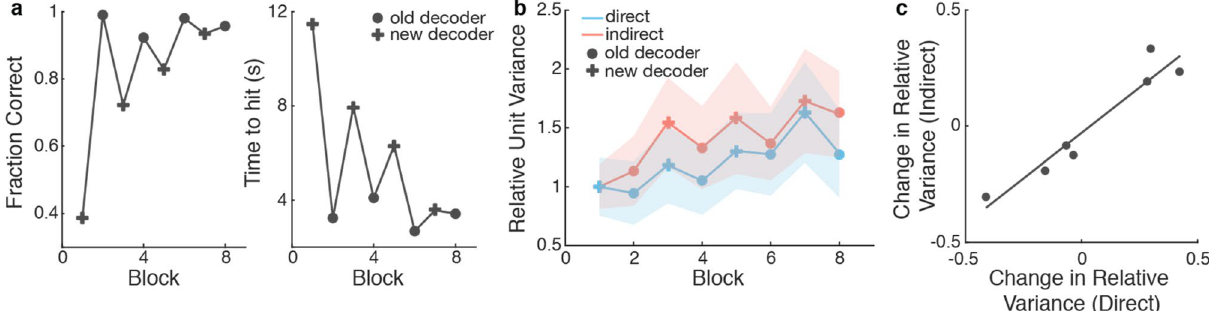
Figure 5. Neural variance modulates concomitantly between subpopulations. ( a ) Monkey P learned to perform BMI with a new decoder following proficient control with the old decoder. 8 experimental blocks were performed, alternating between a new decoder (cross) and the previously learned decoder (circle). Fraction of initiated trials that were successful increased over training blocks (left) and the time to reach a target decreased over training blocks (right). ( b ) Both subpopulations increase their neural variance over blocks (Linear regression; Direct R 2 = 0.623, p = 0.020, Indirect R 2 = 0.655, p = 0.015). The relative variances across blocks are correlated between subpopulations (Pearson’s r, r = 0.856, p = 0.007). ( c ) Each point represents the change in relative variance between two consecutive blocks. The changes in relative variance within the direct and indirect subpopulations are correlated (Pearson’s r, r = 0.820, p =